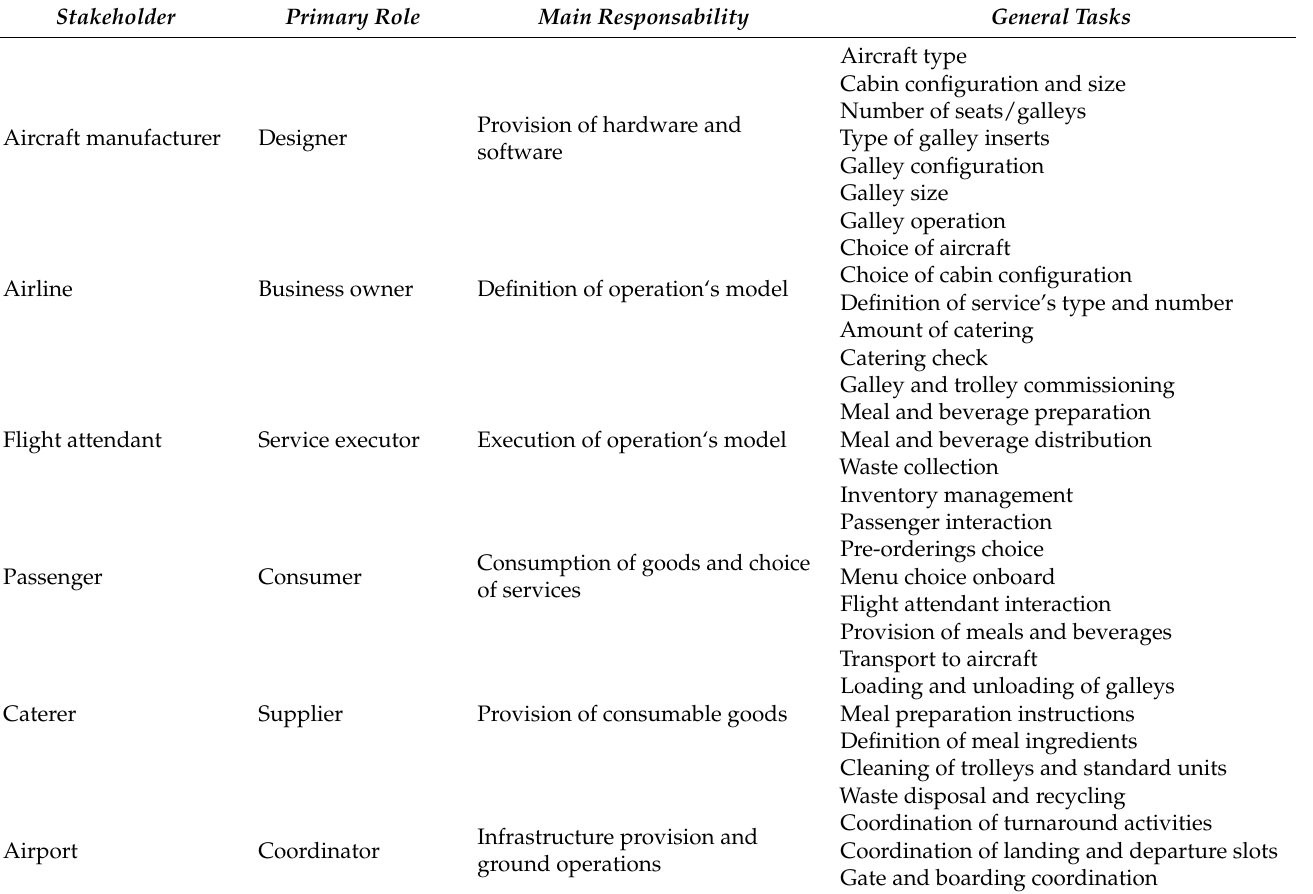
Table A5. General overview of stakeholders with tasks.